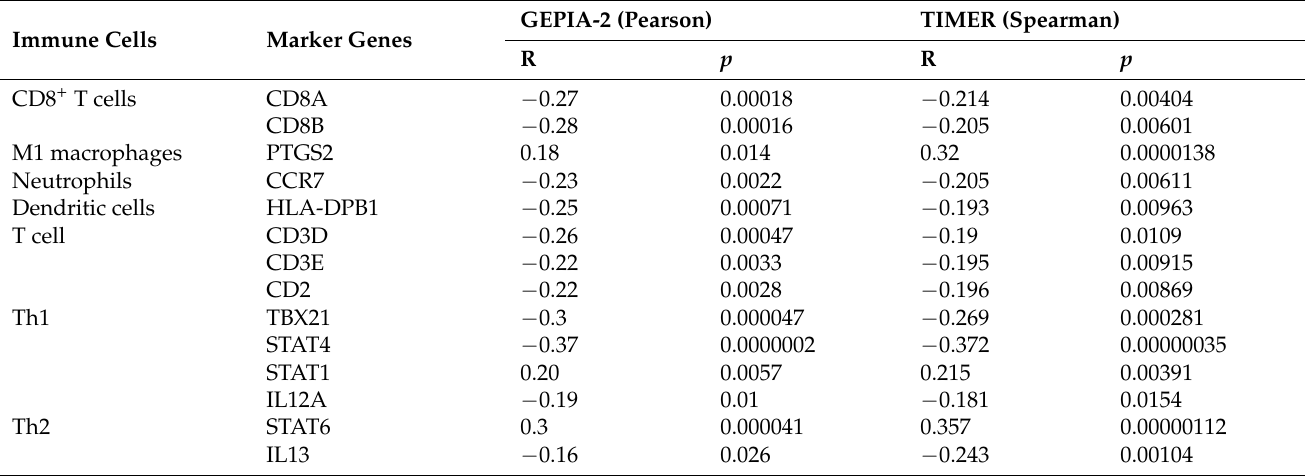
Table 3. Correlation analysis between FERMT1 and immune cell markers using TIMER and GEPIA2 databases.